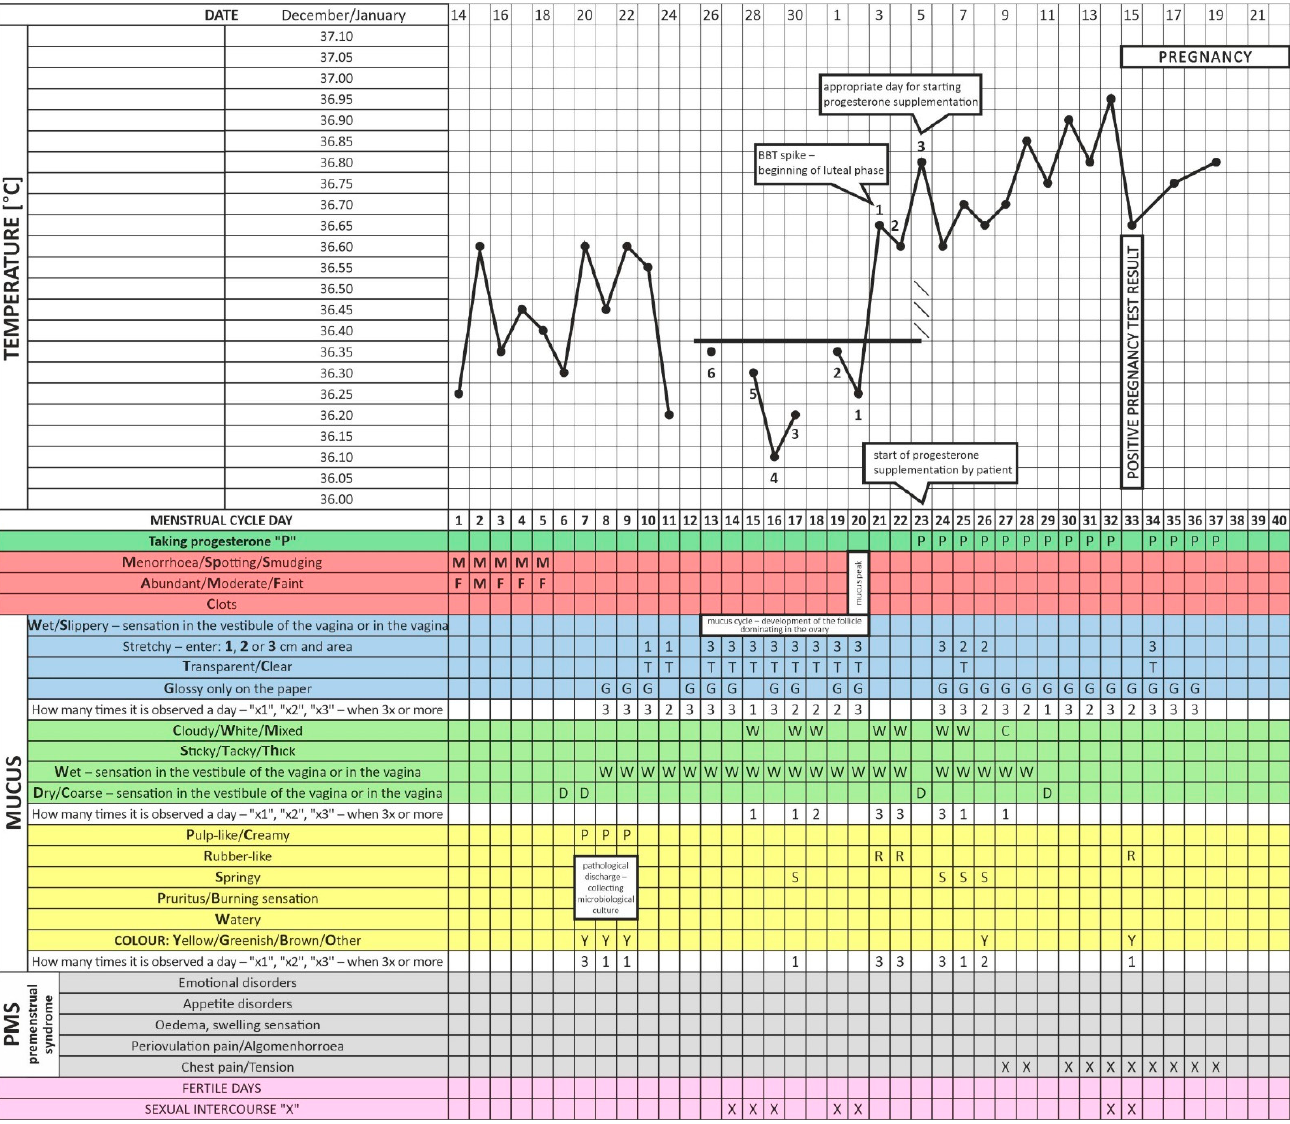
Figure 3. Menstrual cycle observation chart at the time when the patient started progestagen (Dydrogesterone) therapy correctly (i.e., on the third day of increased BBT (the patient conceived in this cycle)).